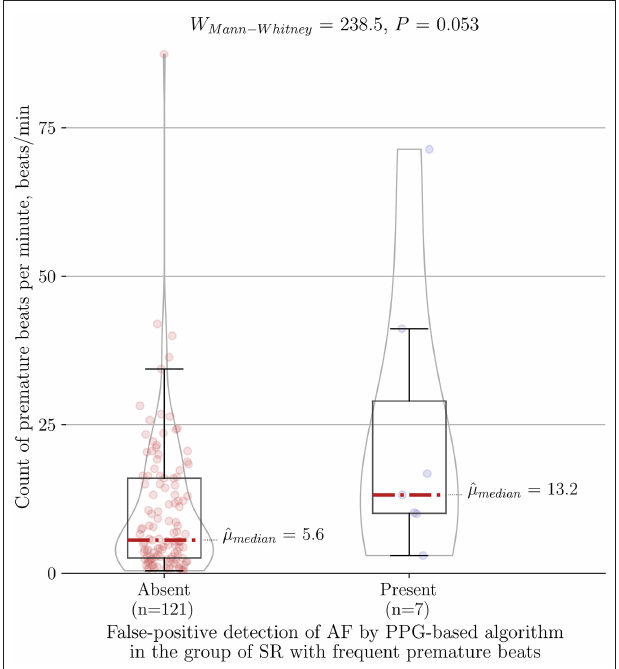
FIGURE 5 | Association between count of premature beats per minute and type I error of the PPG-based algorithm for AF detection in the control group of SR with frequent premature beats ( n = 128). PPG, photoplethysmography; AF, atrial fibrillation; SR, sinus